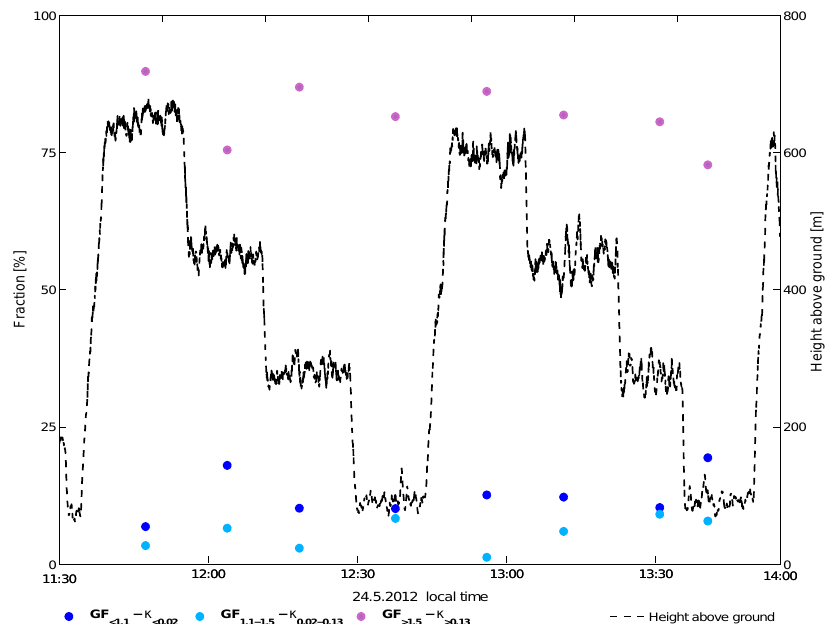
Figure 12. Time evolution of the mixing state of the aerosol particles (with D dry = 500nm) for the height profiles near Cabauw on 24 May 2012. Particles are classified into three hygroscopicity categories according to their GF (equally defined as for Fig. 4): GF < 1.1, 1.1 < GF < 1.5, GF > 1.5, in blue, light blue and pink respectively; these correspond to κ < 0 . 02, 0 . 02 < κ < 0 . 13 and κ > 0 .